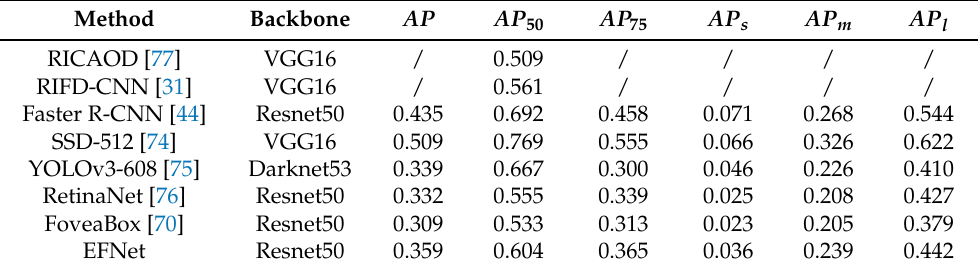
Figure 8. Qualitative examples on HRRSD by EFNet. The TPs, FPs, and FNs are indicated by green, red, and yellow boxes, respectively. Table 3. Object-detection results of comparative methods on